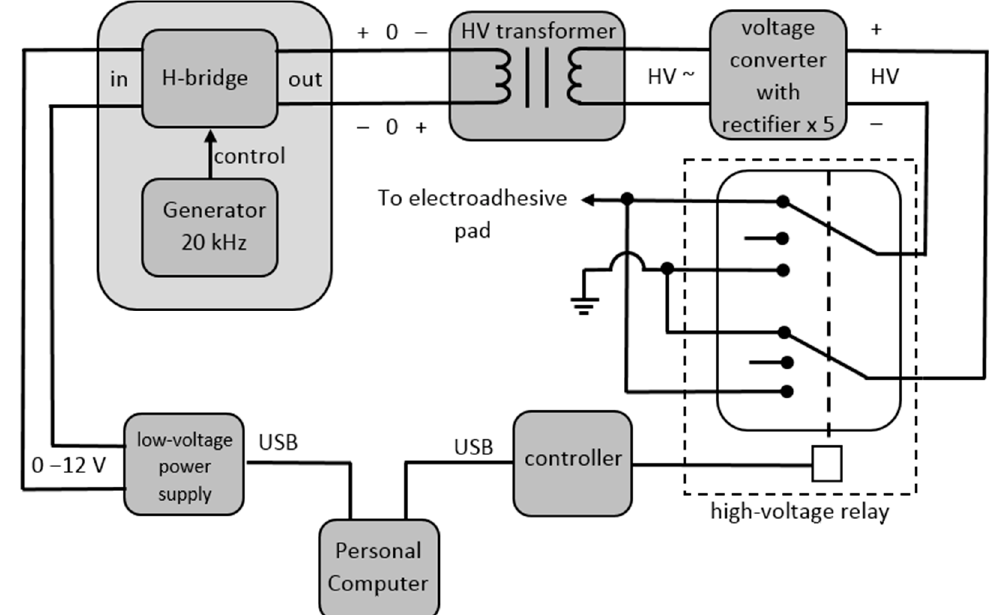
Figure 1. Power supply system.